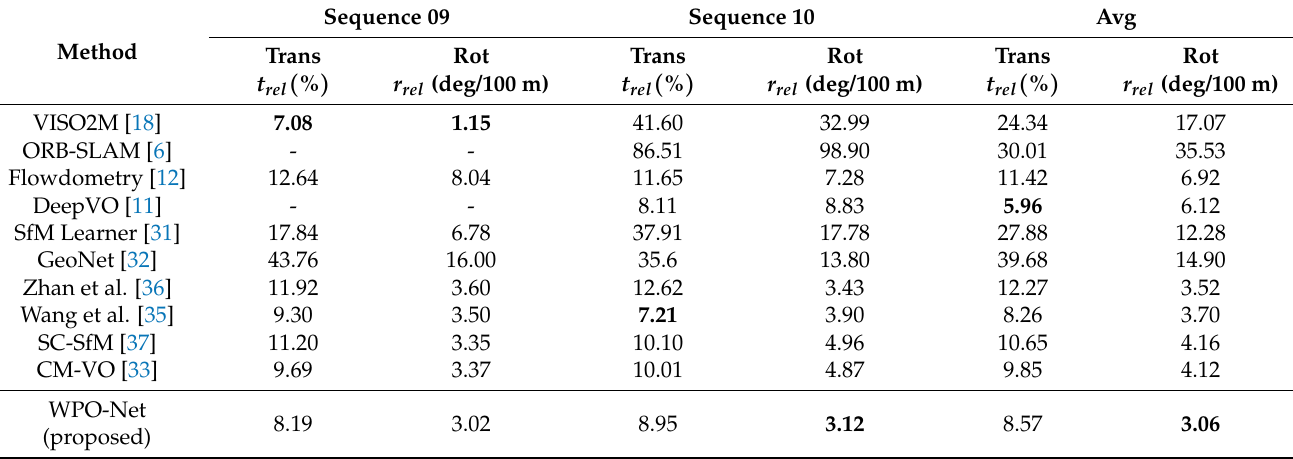
Figure 3. Comparison of rotational and translational errors of different DA quantities at subsamples of varying length (100 m, 200 m, 300 m, ..., 800 m) sequences 09 and 10. Table 3. Comparative results on the KITTI benchmark (data is extracted from the corresponding works/citations, the least error results are high-lighted in bold